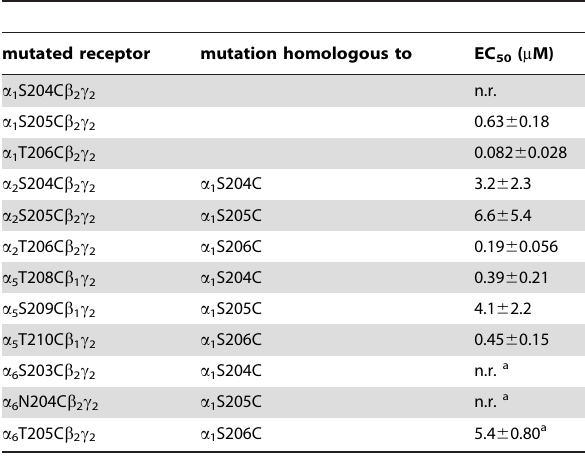
Table 1. Concentration dependence of the covalent reaction at mutant receptors at the binding level.